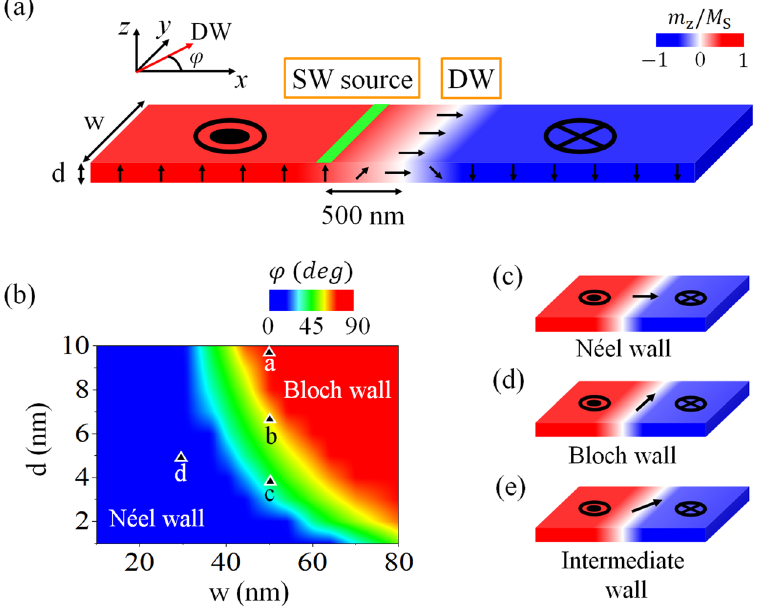
Figure 1. ( a )Schematics of the sample geometry for simulation. The nanostrip is 4 µ m long, with a domain wall located at the center, and a spin wave source 0.5 µ m to the left. ( b ) Phase diagram of the equilibrium DW structure for width w ranging from 10 to 80 nm and thickness d from 1 to 10 nm. The structures of the DW correspond to ( c ) the Néel wall (center magnetization azimuthal angle ϕ = 0 or 180° to the x axis in the xy plane), ( d ) the Bloch wall ( ϕ = 90 or 270°), and ( e ) an intermediate